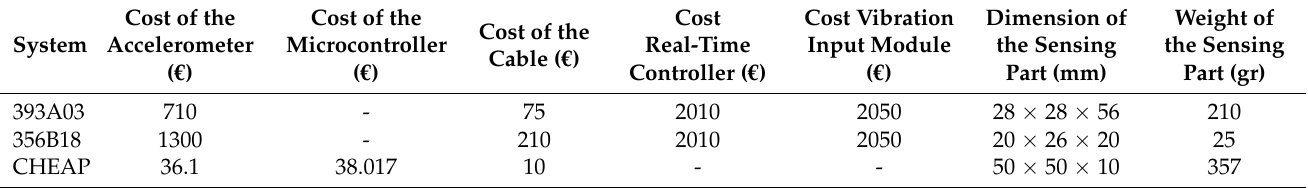
Table 5. Price comparison of the three